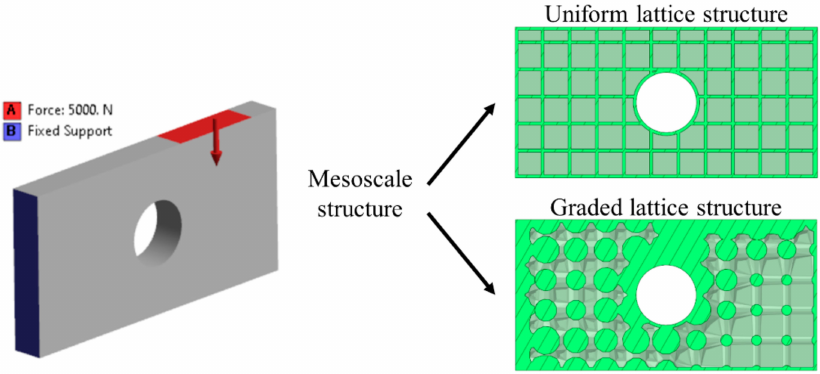
Figure 2. The difference between uniform lattice structure and graded lattice